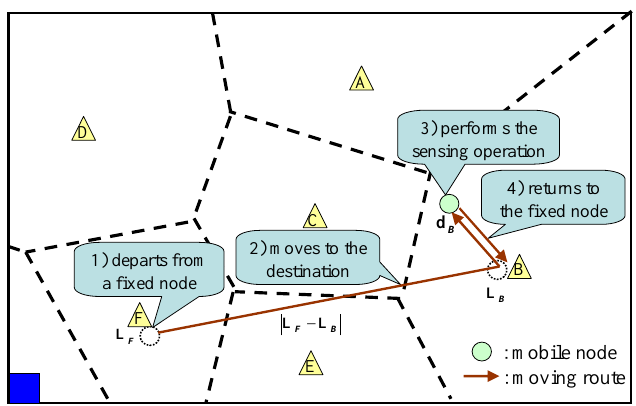
Figure 10. The operations in a sensing